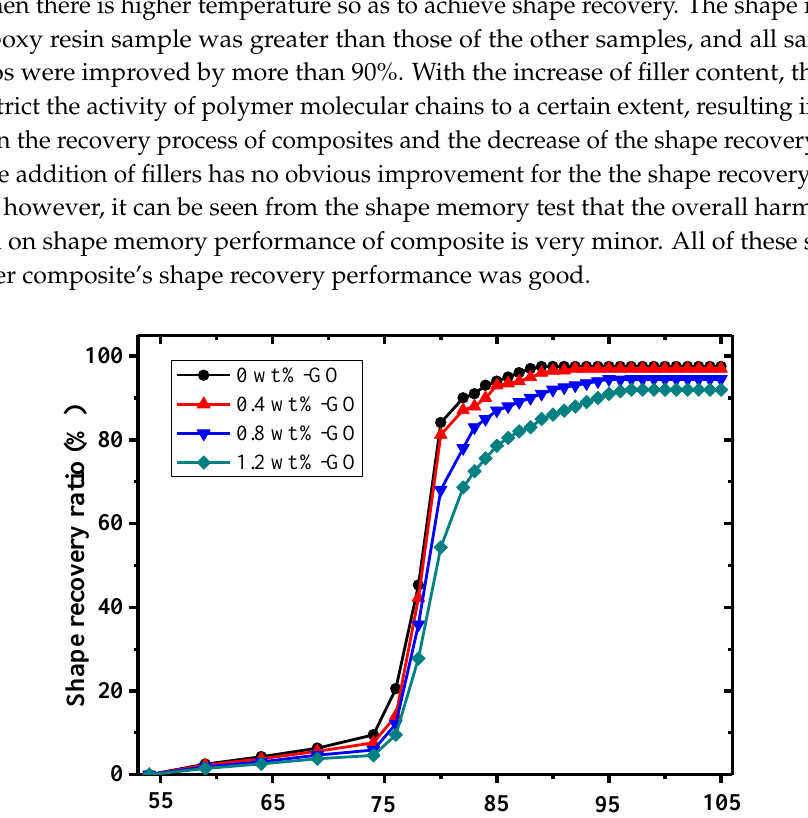
Figure 14. The shape recovery ratio of SMEP composites with different GO contents at different temperatures.